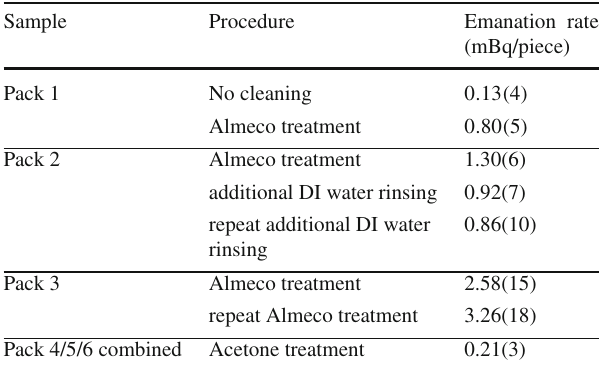
Table1 Radonemanationresultsofdistillationpackingmaterialbefore and after selected cleaning procedures